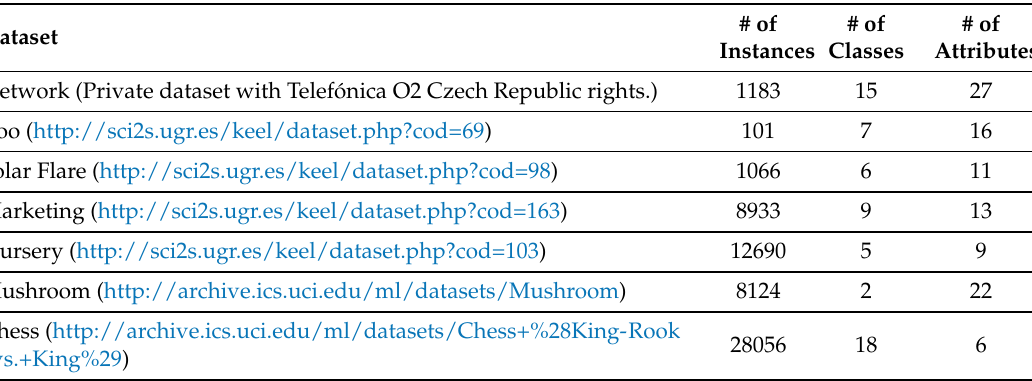
Table 2. Datasets’